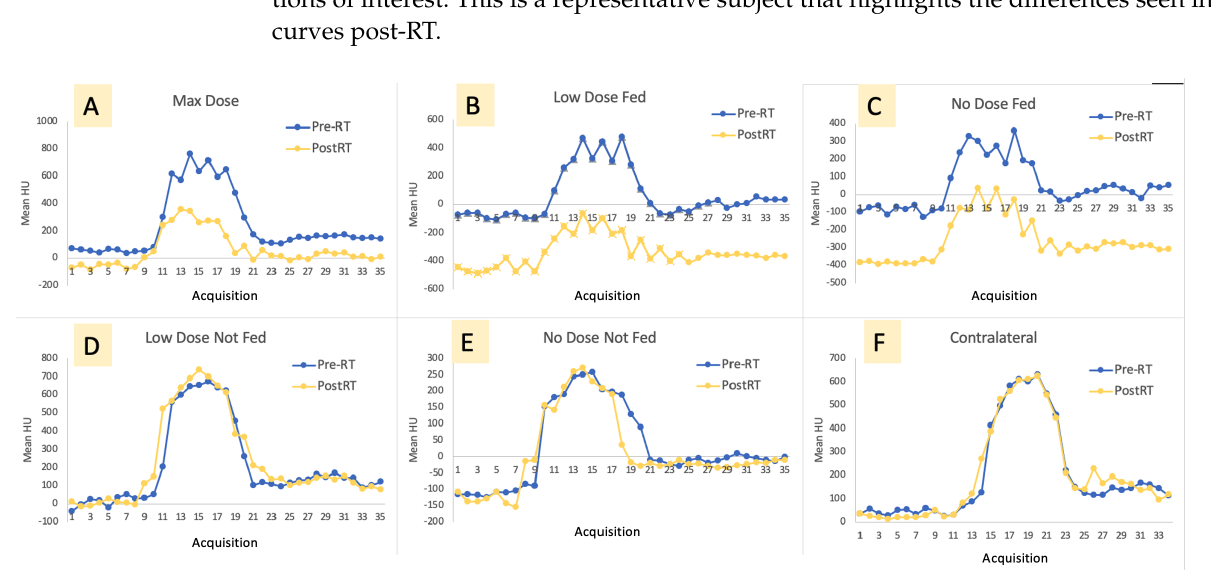
Figure 5. Representative contrast curves pre- and post-RT in an example subject in the max dose contour ( A ), low-dose fed contour ( B ), no-dose fed contour ( C ), low-dose not-fed contour ( D ), no-dose not-fed contour ( E ), and contralateral lung ( F ). There is little change in the not-fed contours and contralateral lung contour, while the fed and max dose contours observe significant change.